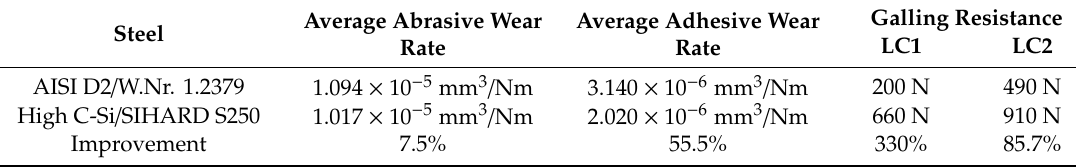
Table 4. Wear resistance of SIHARD S250 in comparison to AISI D2 tool steel at a hardness level of ~62 HRC.